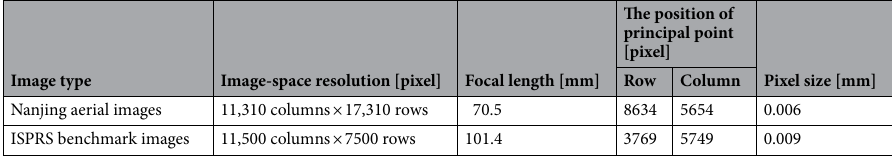
Table 1. Interior orientation parameters of experimental aerial images.